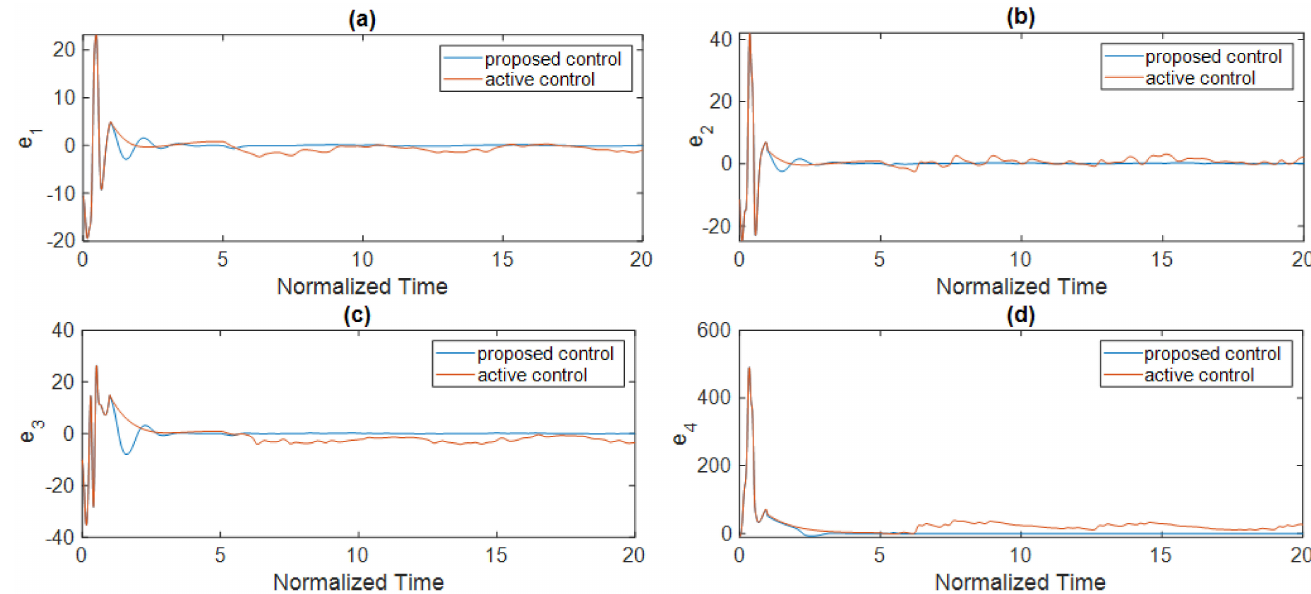
Figure 9. The error of synchronization based on the proposed control methodology and active control, where there are both bias faults and partial loss of effectiveness. Time history of ( a ) e 1 , ( b ) e 2 , ( c ) e 3 , ( d ) e 4 .